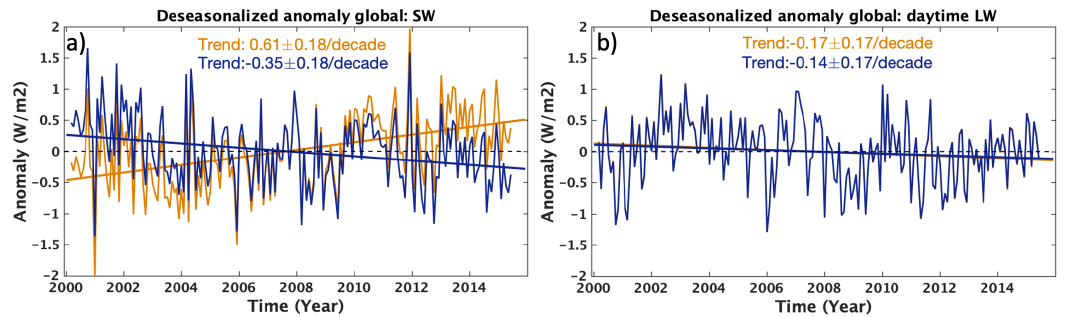
Figure 3. Anomaly in global monthly mean TOA SW fluxes ( a ) and TOA daytime LW fluxes ( b ) using cloud optical depth from Ed4 retrieval (navy lines) and imposing a 0.005 per month trend in Ed4 cloud optical depth for all cloudy footprints of Ed4 (orange lines).